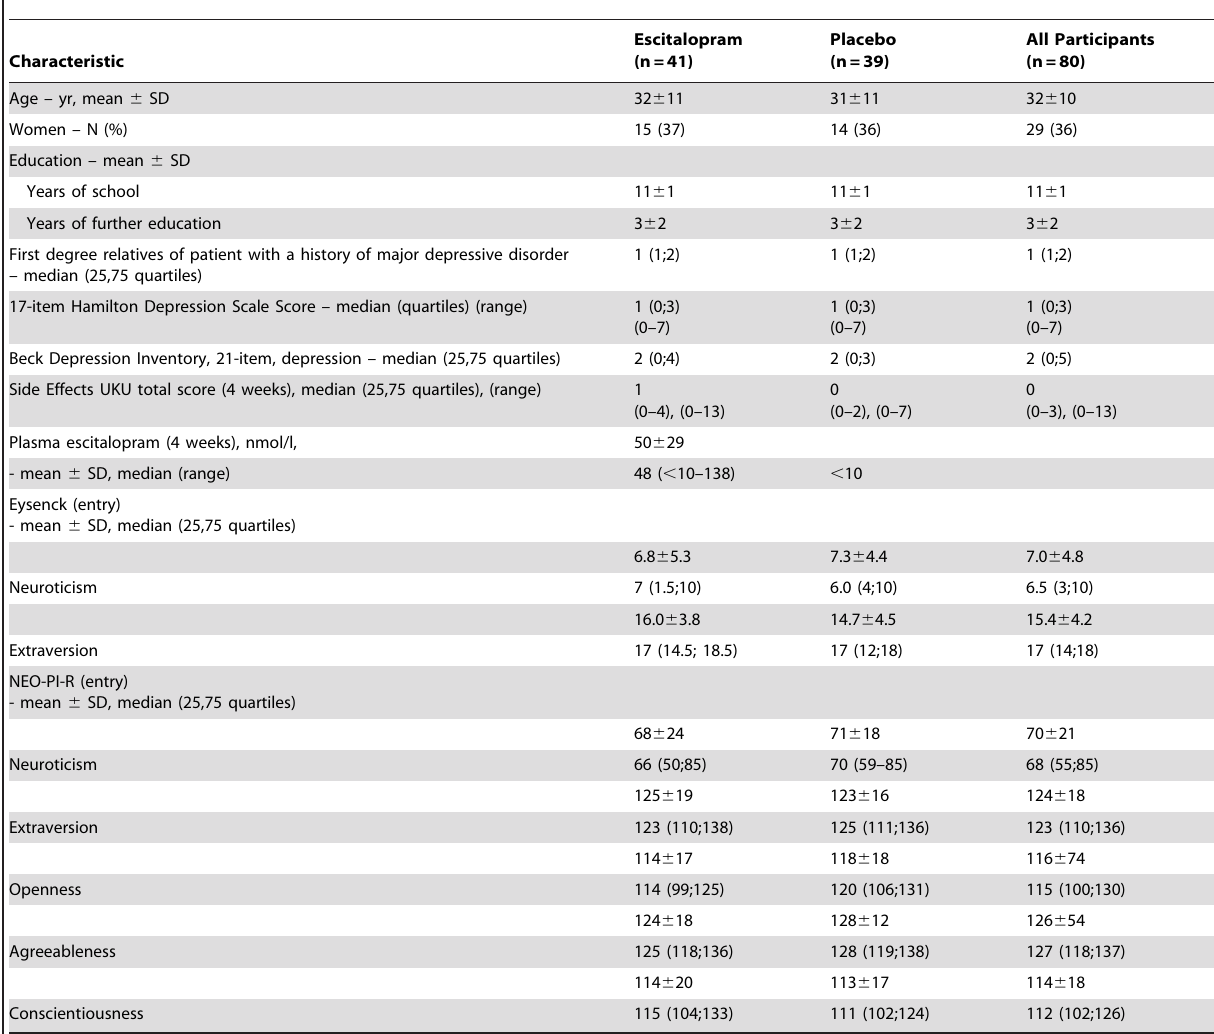
Table 1. Clinical and demographic characteristics of participants in the Agenda